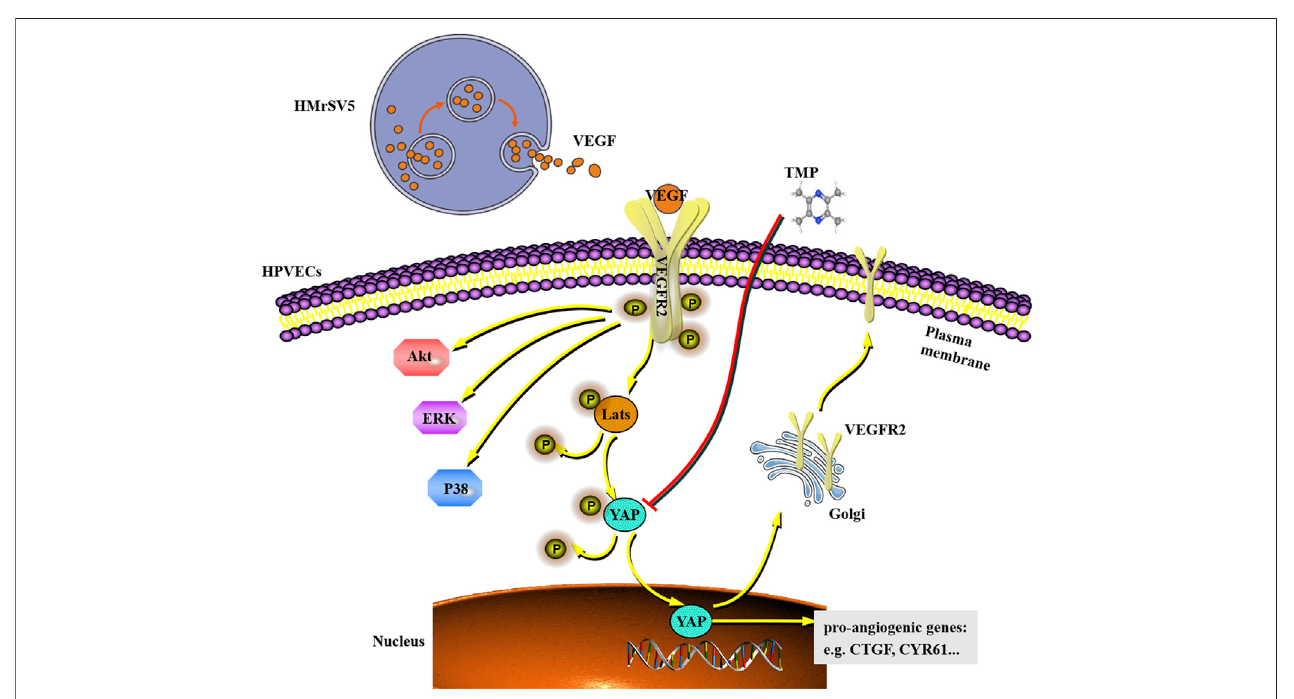
FIGURE 9 | Working model shows that VEGF derived from HMrSV5 regulates the migration and tube formation of HPVECs via a mechanism which involves YAP nuclear translocation. As a small molecule inhibitor, TMP weakens YAP nuclear translocation and VEGFR traf fi cking induced by YAP, which may even further ameliorate activation of VEGFR downstream